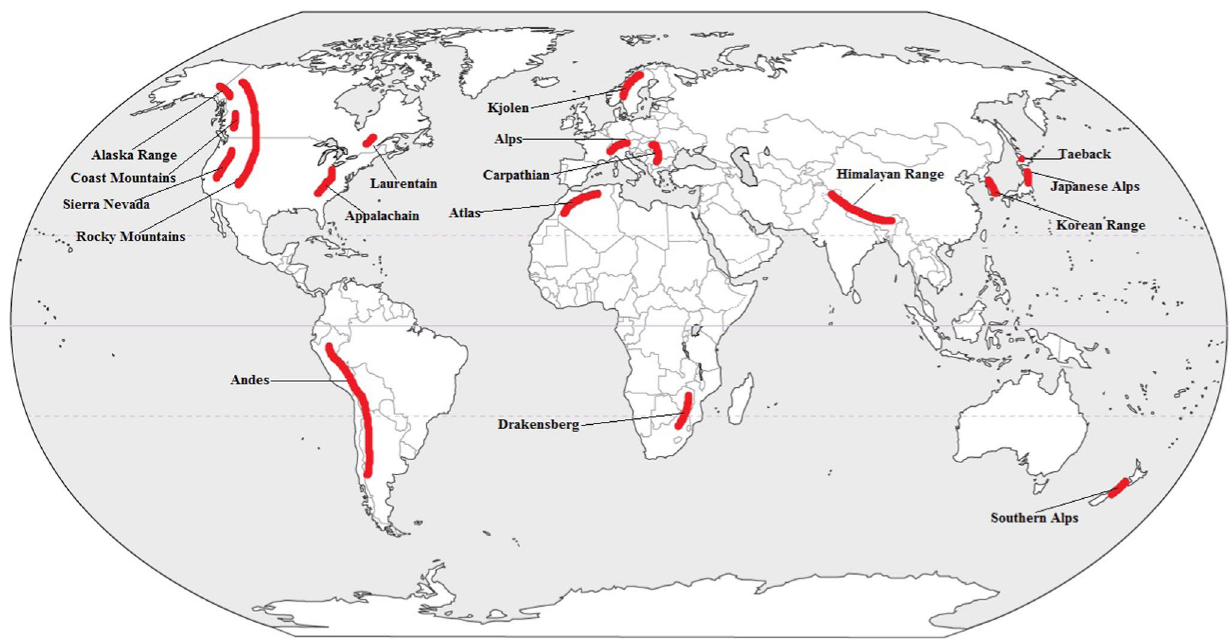
Fig. 1 Location of different high-altitude regions around the globe. Adopted from nationsonline.org